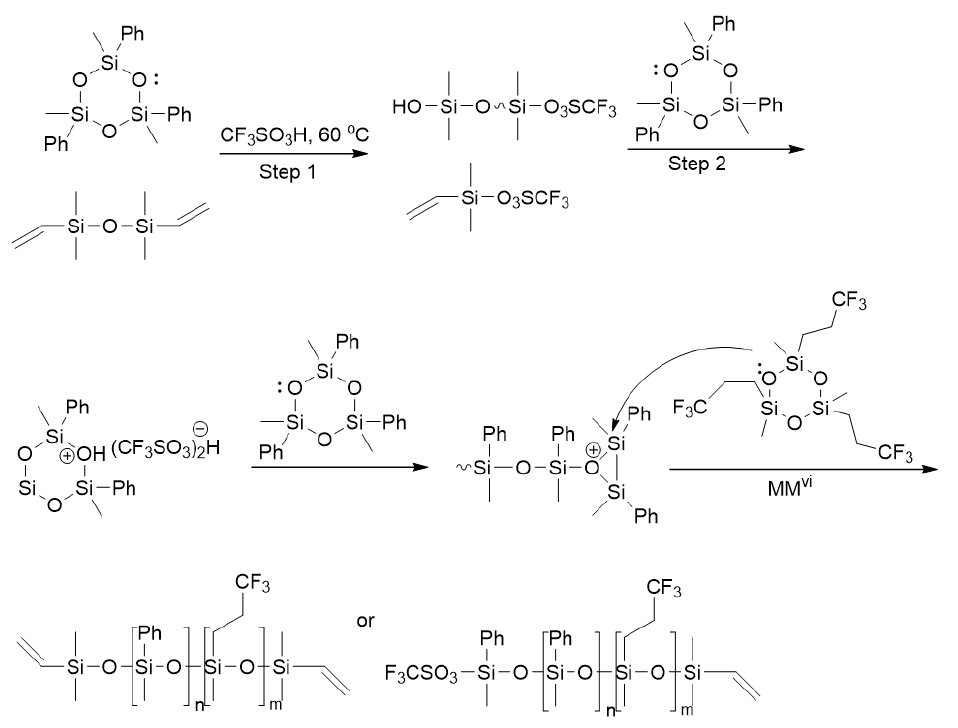
Figure 38. Possible mechanism of copolymerization of D 3F and D 3Ph initiated by CF 3 SO 3 H (adapted with permission from Ref. [157]. 2016. Fei, H.F)